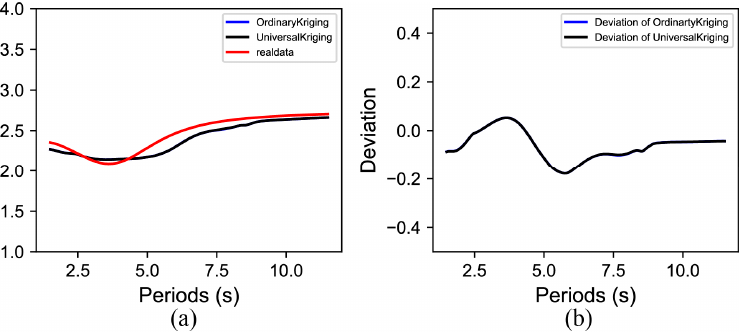
Figure A3. Comparison of dispersion curve interpolation results (128.0° E, 42.0° N ). The blue curve indicates the ordinary kriging results, while the black curve indicates those of universal kriging: ( a ) Comparison of the dispersion curves; and ( b ) deviation of the OK (blue) or UK (black) results.